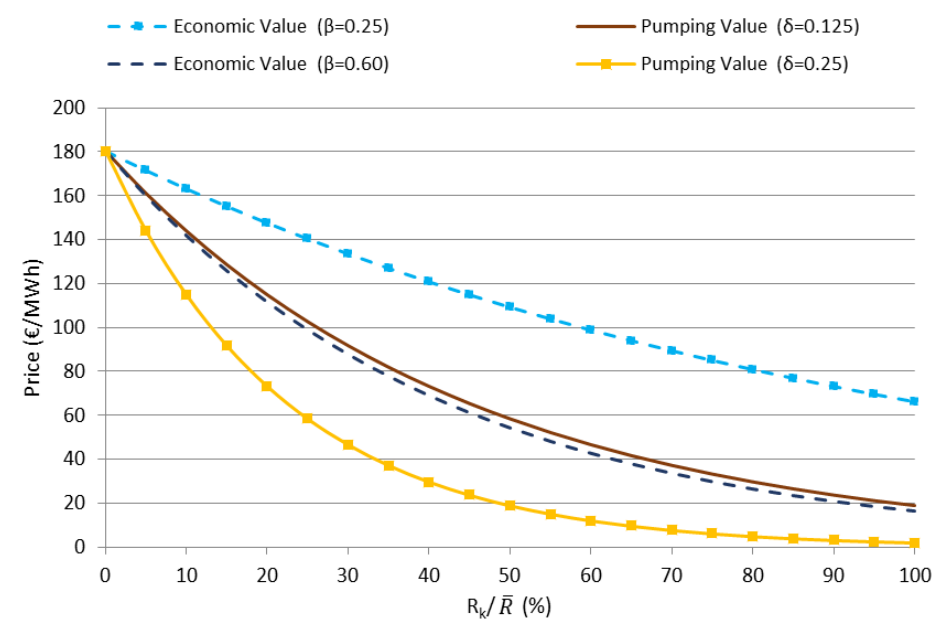
Figure 4. Exponential functions for computing the (economic and pumping) values of